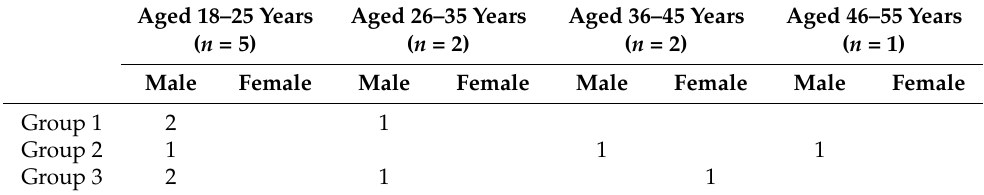
Table 1. Participants from the ICs by age and